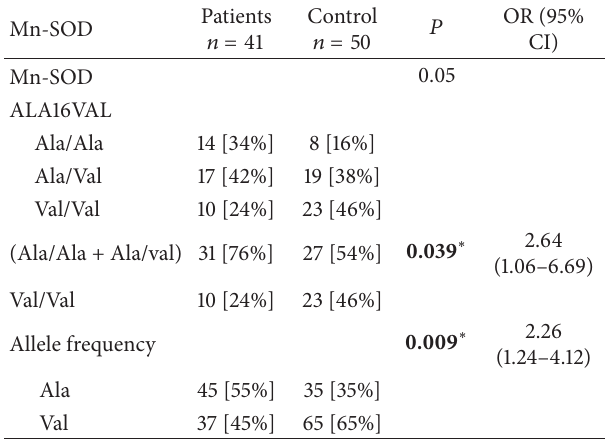
Table 3: Distribution of Mn-SOD (Ala16Val) polymorphism in patients with RCC and